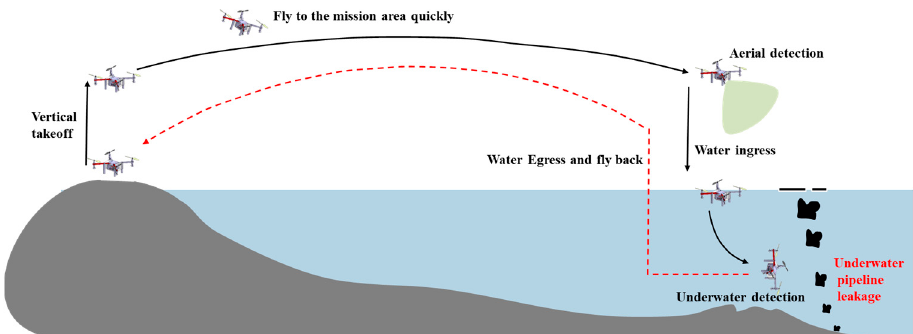
Figure 1. Water–air medium detections for underwater pipeline leakage.